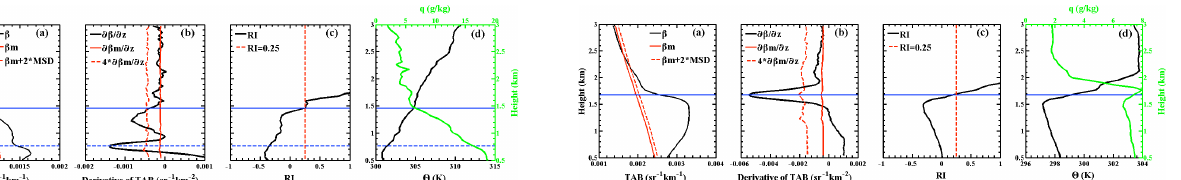
Figure 4. Illustrations of the MPL BLH and MLH identification methods for oceanic measurements (23:30, Mar 03, 2007): (a) TAB; (b) TAB gradient; (c) RI; (d) potential temperature and mixing ratio. The blue solid line in each figure denotes the Sonde derived BLH, and the blue dashed line denotes the MPL derived MLH.